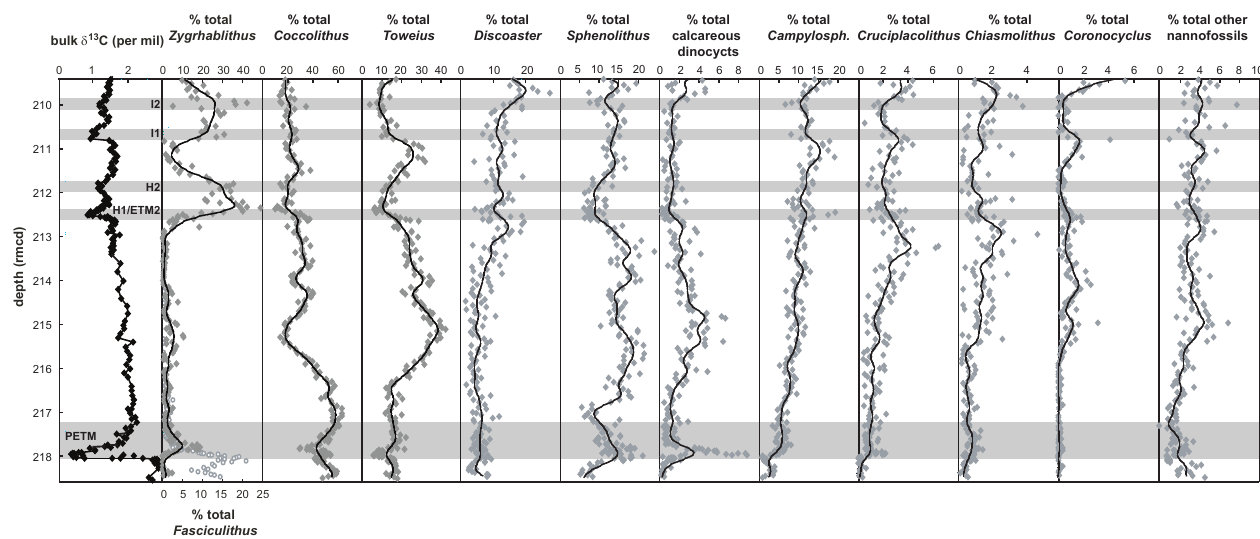
Fig. 1. Abundances of the most common taxa across the focal interval, illustrating raw percent data (grey diamonds) and the SiZer smoothed records (black lines), on a depth scale. In the first panel is the bulk carbonate carbon isotope record (Zachos et al., 2003; Murphy et al., 2006) with the CIE intervals highlighted in grey. Campylosp. – Campylosphaera . Depth – revised metres composite depth (rmcd, Westerhold and R¨ohl,